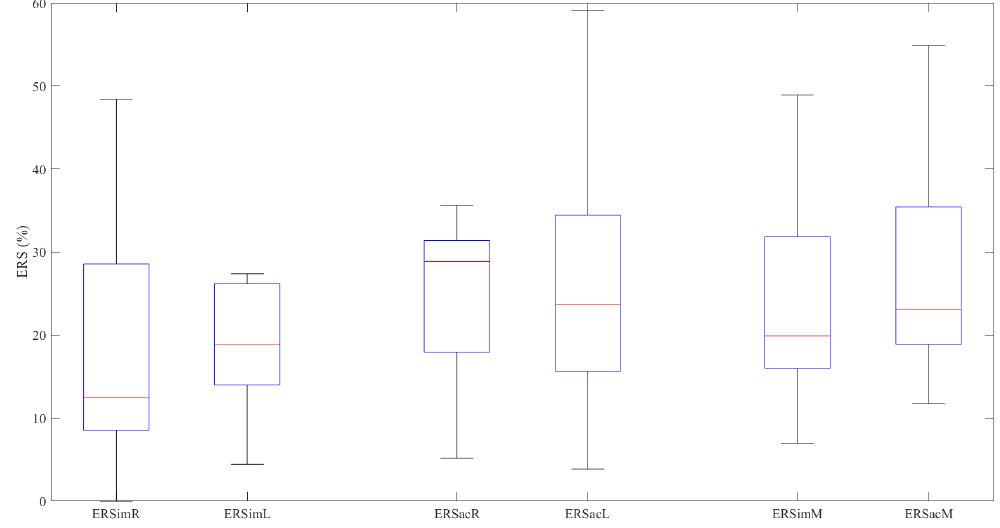
Figure 2. ERS values (%) in the various experiments.